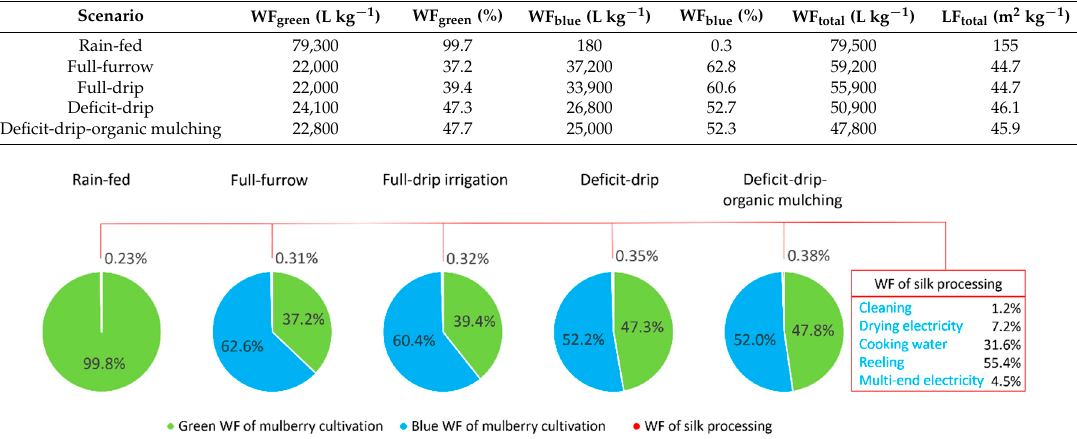
Figure 3. The composition of the water footprint (WF) of raw silk, by colour and by production stage, for five mulberry cultivation scenarios.